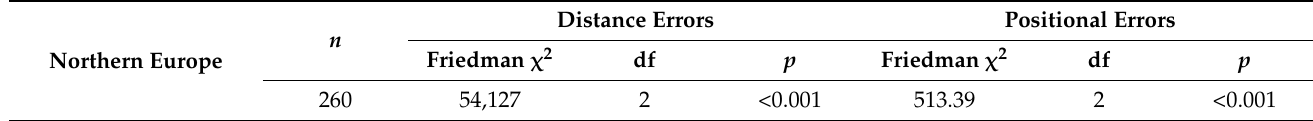
Table 2. For distance errors and positional errors in the Northern European Area, the total sample size, n , Friedman chi-square, χ 2 , the degrees of freedom for Friedman chi-square, df; the p -value, p , were reported. Distance Errors Positional Errors n